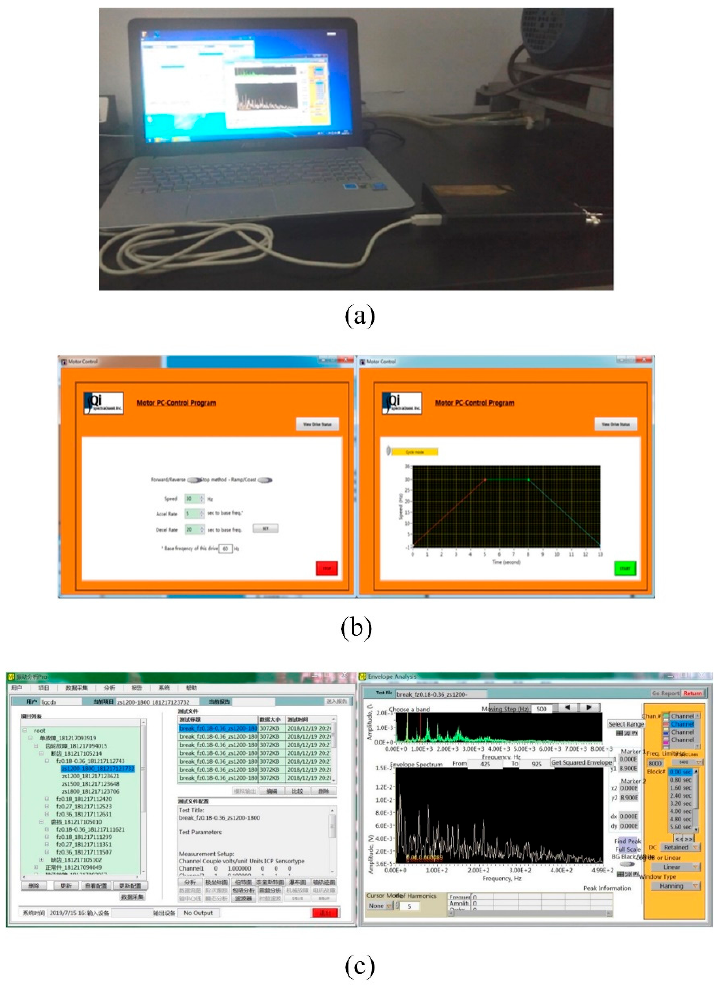
Figure 12. ( a ) Data collection systems; ( b ) motor control software; ( c ) VibraQuest Pro software.